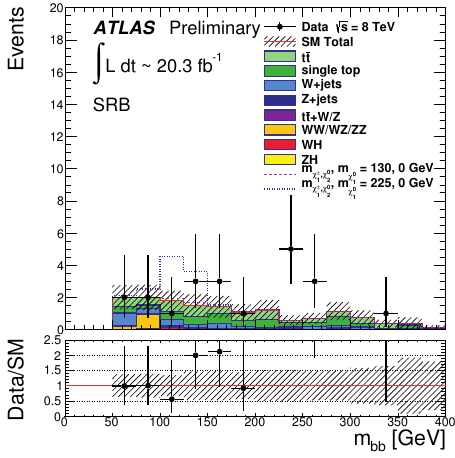
Figure 14: Distribution of m bb for region SRA, sensitive to low ˜ χ